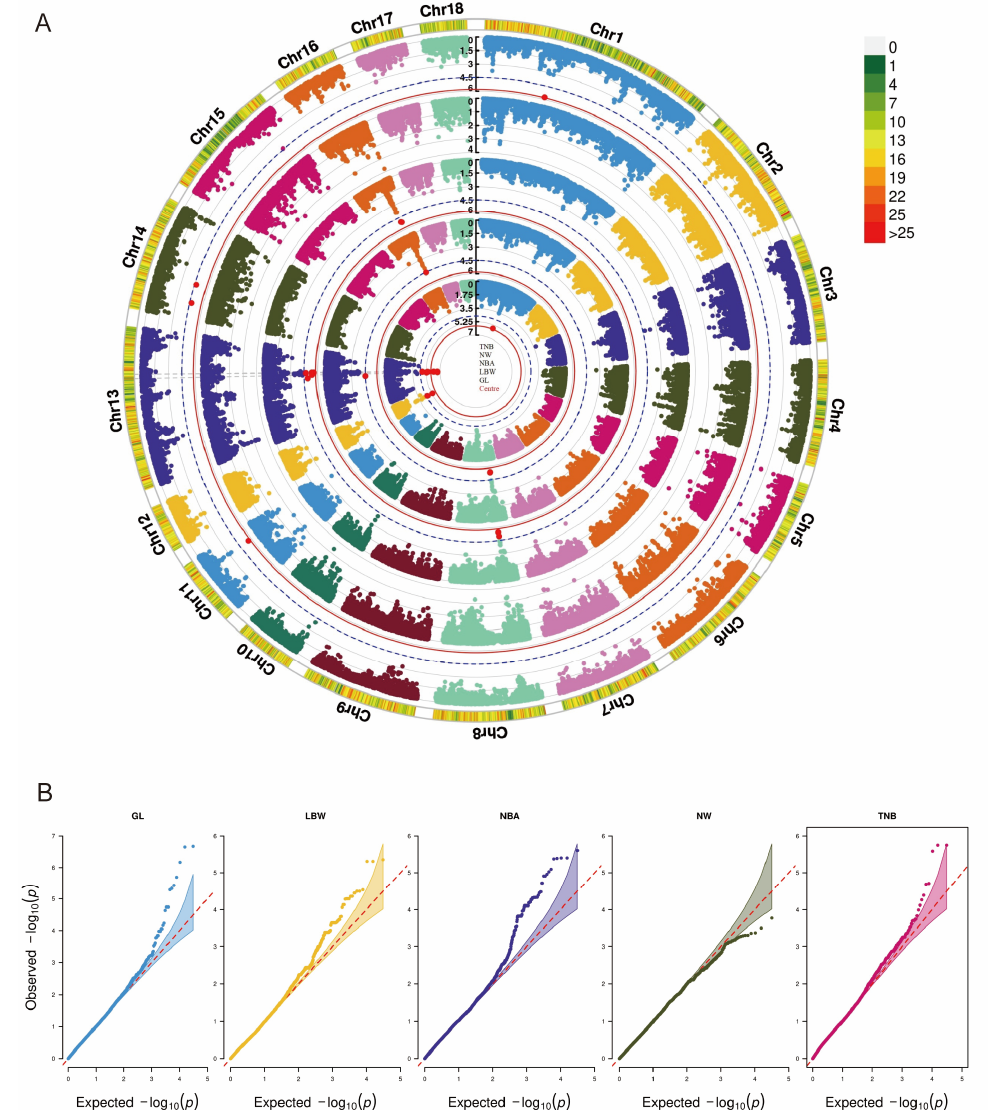
Figure 1. Manhattan and Q-Q plots of GWAS based on chip data for five reproductive traits. ( A ). The red line represents the genome-wide significance level. The blue line represents the suggestive significance (3.01 × 10 − 5 ). Red spots identify SNPs with genome-wide significance (1.60 × 10 − 6 ). Traits from the inner to outer lanes are gestation length (GL), litter birth weight (LBW), number born alive (NBA), number of weaned (NW), and total number born (TNB). ( B ). Q-Q plots of five reproductive traits. Table 4. The significant SNPs in the genome for the gestation length (GL) trait using chip data in pigs.